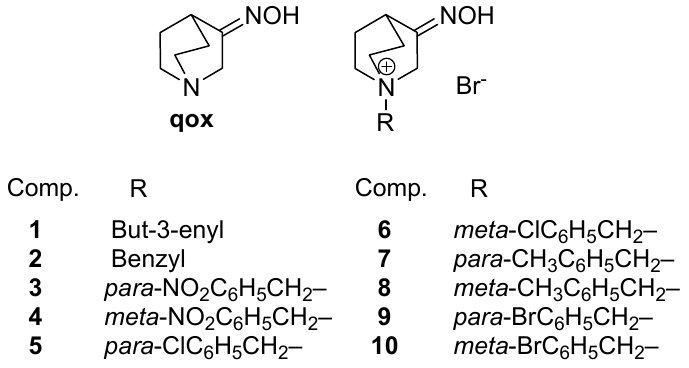
Figure 2. Synthesized compounds: 3-hydroxyiminoquinuclidine ( qox ) and quaternary derivatives 1 – 10 .